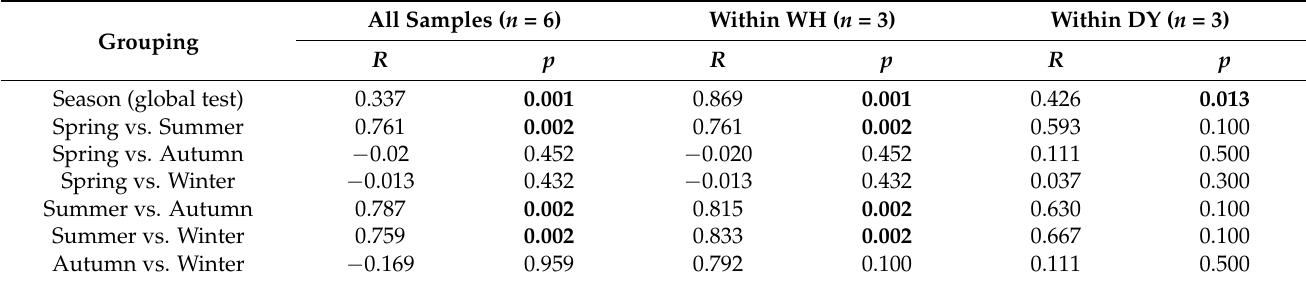
Table 1. ANOSIM testing the seasonal differences in benthic archaeal community structure based on weighted UniFrac metrics. All Samples ( n =